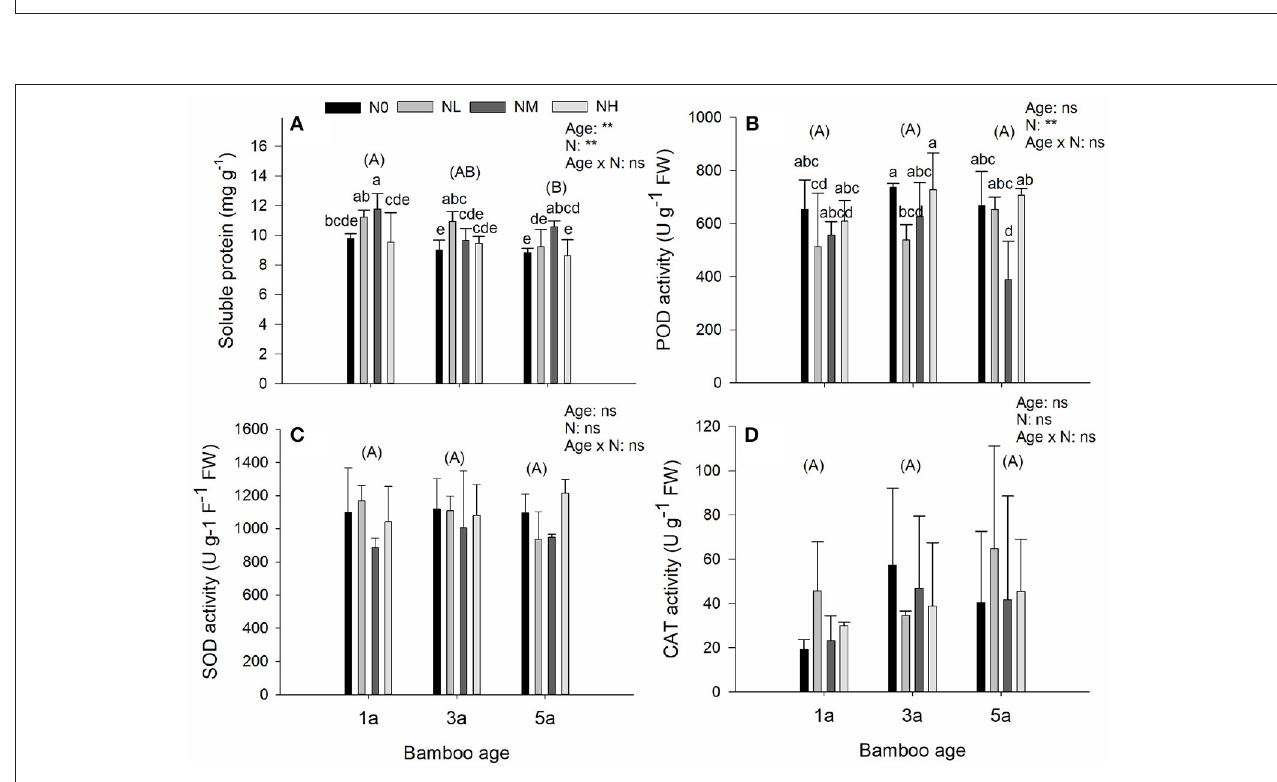
FIGURE 4 | Effects of nitrogen deposition and tree age on soluble protein contents and antioxidant enzyme activities in Moso bamboo leaves in a factorial experiment. One-year-old (1a), 3-year-old (3a), and 5-year-old (5a) trees were included in the experiment. Nitrogen deposition treatments: Ambient deposition with no addition (N0, control), low addition (NL = 30kg N ha − 1 year − 1 ), medium addition (NM = 60kg N ha − 1 year − 1 ), and high addition (NH = 90kg N ha − 1 year − 1 ). Each treatment had three replicates ( n = 3). (A) Soluble protein content, (B) peroxidase activity (POD), (C) superoxide dismutase activity (SOD), and (D) catalase activity (CAT). For each parameter mean ± SE is indicated. Bars with different lower-case letters indicate significant differences between all combinations of treatment and age, whereas groups of bars with different upper-case letters in parentheses indicate significant differences between the tree age classes ( α = 0.05 in post-hoc one-way ANOVA combined with pair-wise Tukey’s tests). A summary of the results of a two-way ANOVA addressing the effects of nitrogen deposition and tree age is seen in the upper right-hand corner of each panel (**0.001 ≤ P < 0.01; ns, non-significant).